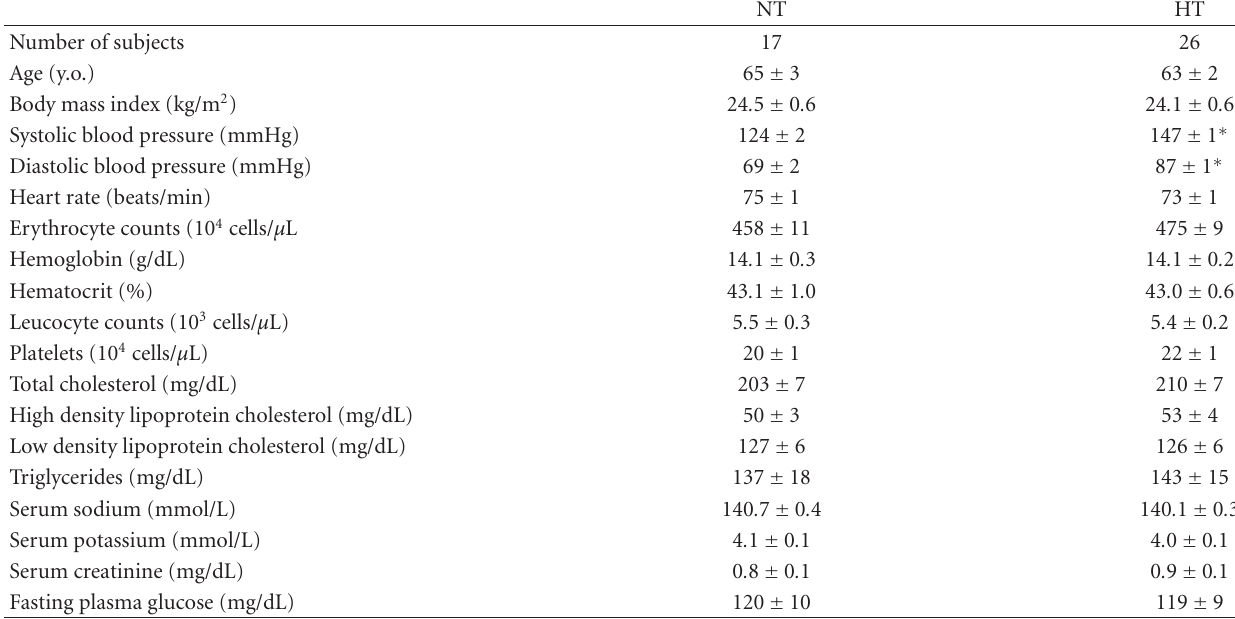
Table 1: Clinical Characteristics and Laboratory Findings of Hypertensive (HT) and Normotensive (NT) Men.